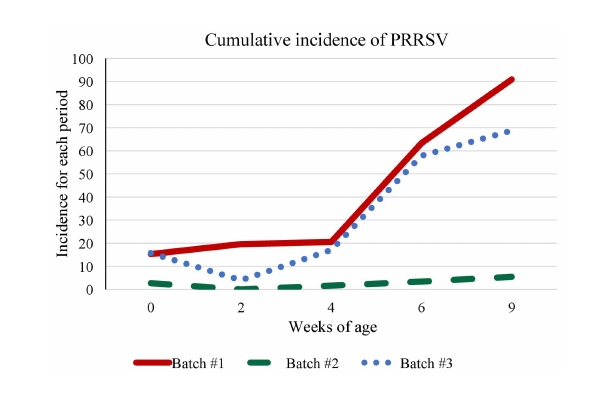
FIGURE 2 Evolution of the cumulative incidence of PRRSV-1. The graph shows the cumulative incidence of PRRSV-1 for each observation period (2, 4, 6, and 9 weeks of age) per batch. The incidence was calculated as the proportion of infected animals over the number of susceptible animals in a given time